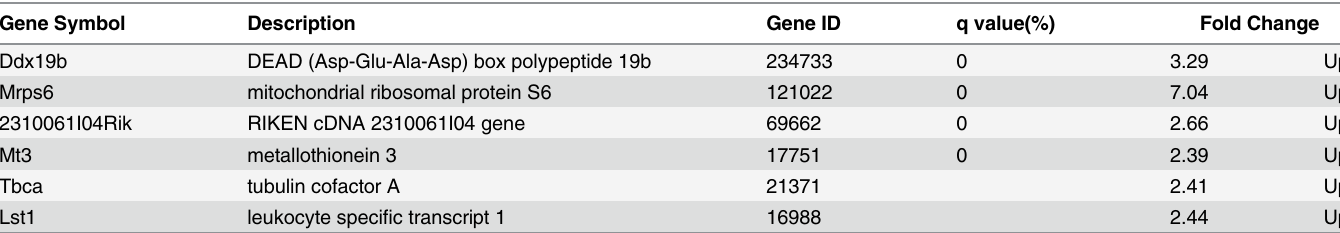
Table 4. Differentially expressed genes in WTR vs WNR